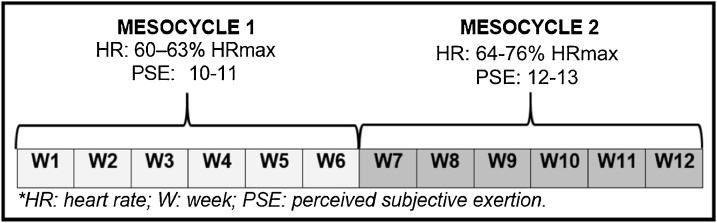
Training protocol.